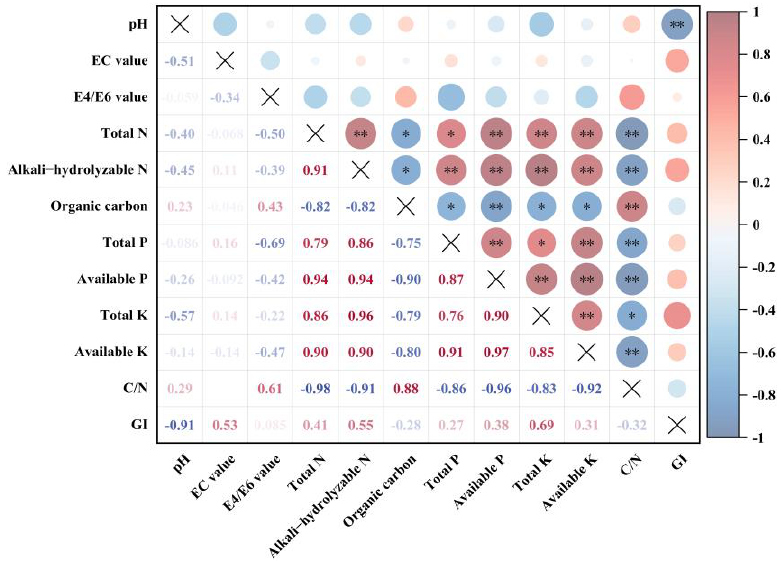
Figure 10. Correlation analysis between indicators related to the treatments during decomposition. * indicates a significant difference ( p < 0.05), and ** indicates an extremely significant difference ( p < 0.01).